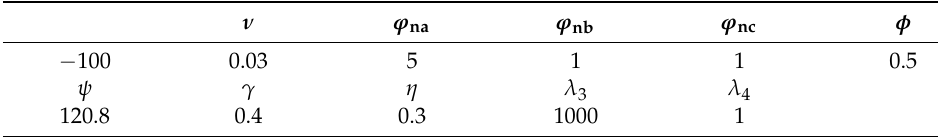
Table 2. Parameters of the STNFOSMCTDE controller.